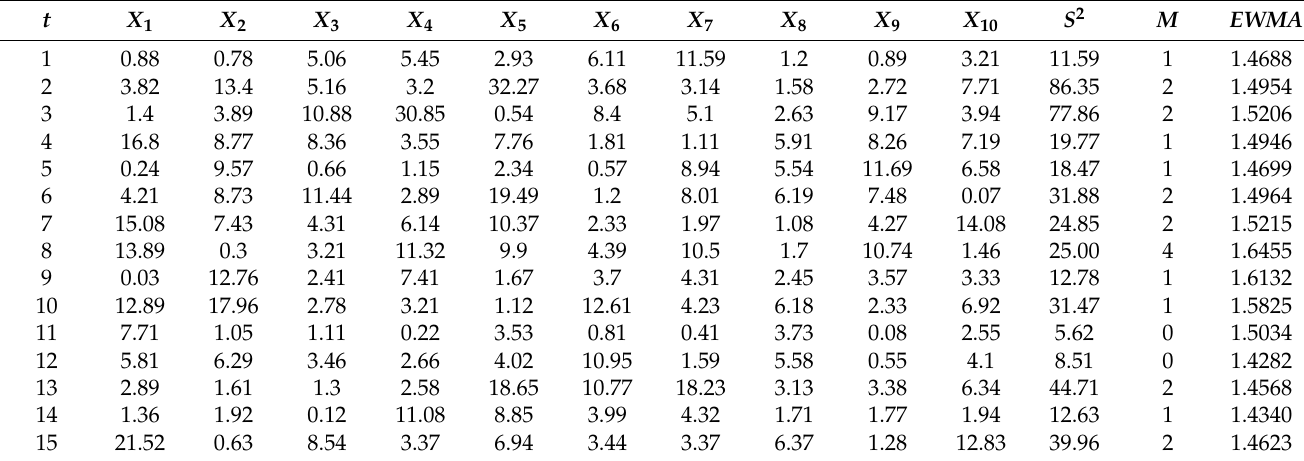
Table 8. The service time from 10 counters in a bank